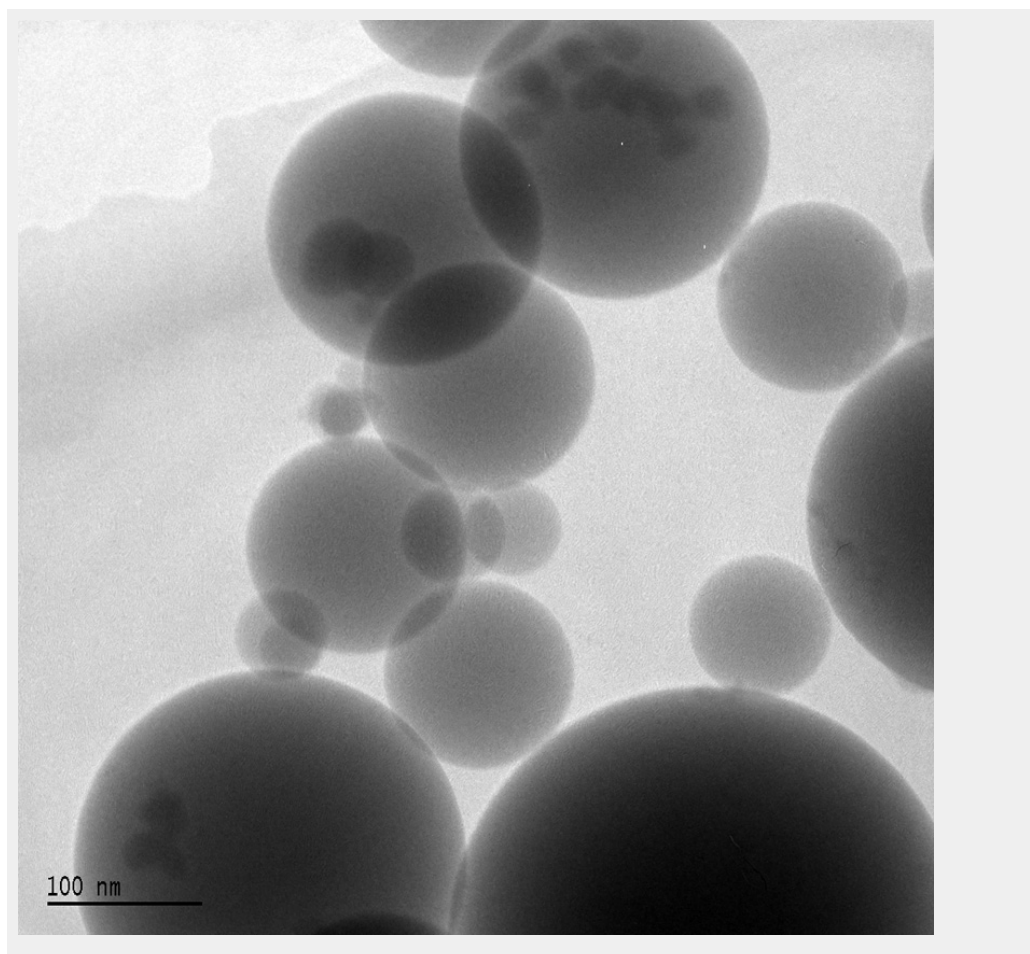
Figure 6 Amorphous “fumed” silica (SiO2) “nano-particles” (ca. 10–200 nm diameter) added to liquid PDMS silicone polymers before they are chemically cross-linked to turn them into silicone rubber. Adding the “nano-particles” results in silicone rubber with improved strength, tear-resistance and increased elongation before failure as tensile loading is increased. Source: Wikimedia Commons, ©